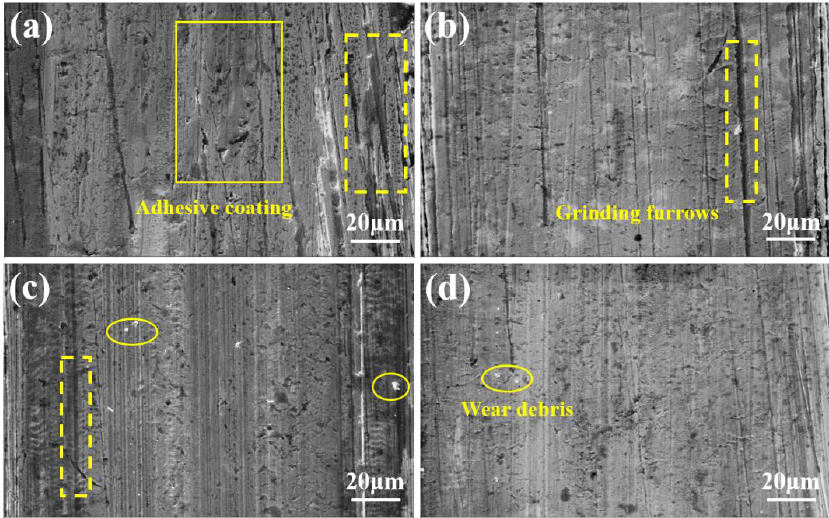
Figure 8. The SEM of coatings after linear reciprocating wear testing ( a ) 1#, ( b ) 2#, ( c ) 3#, ( d )